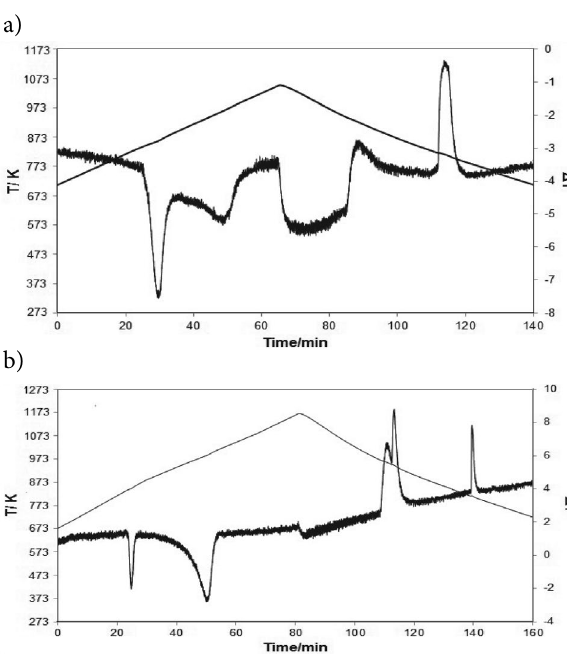
Figure 5. Thermograms for (SnAs) 0.4 (GeAs) 0.6 (a) and (SnAs) 0.15 (Ge Figure 7. T-x diagrams of polythermal sections SnAs–Ge